Question: From the figure, is the trend upward or downward?
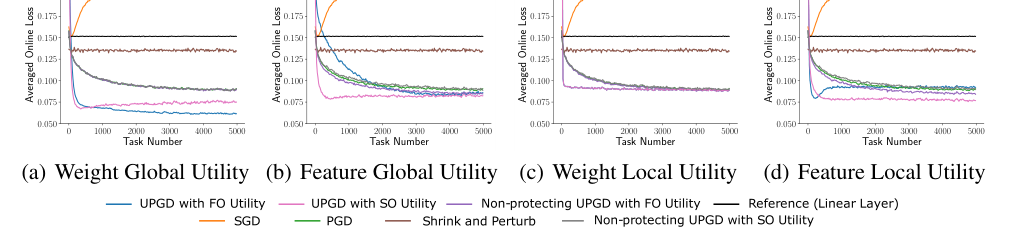
Answer: increasing